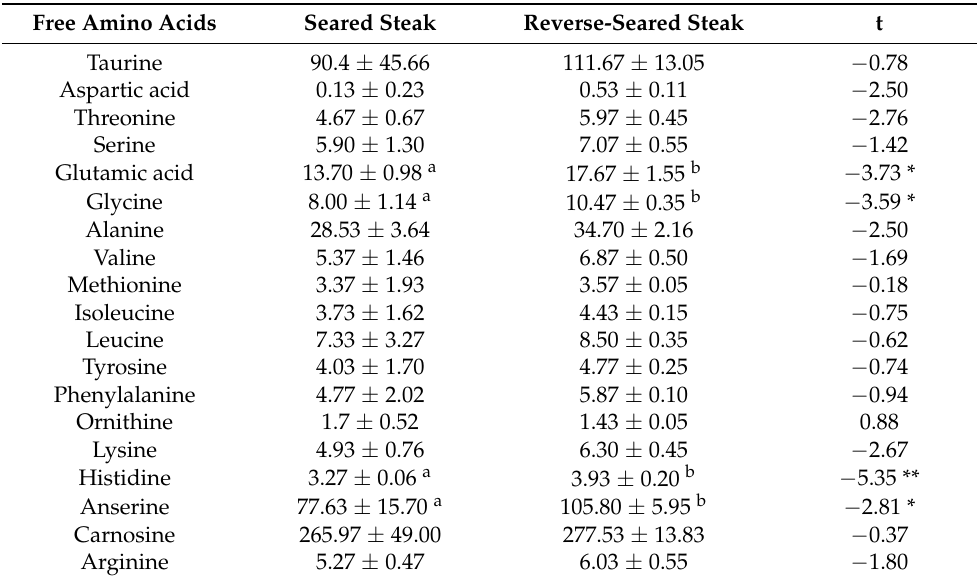
Table 2. Free amino acids (mg/100 g) in seared and reverse-seared steaks. Free Amino